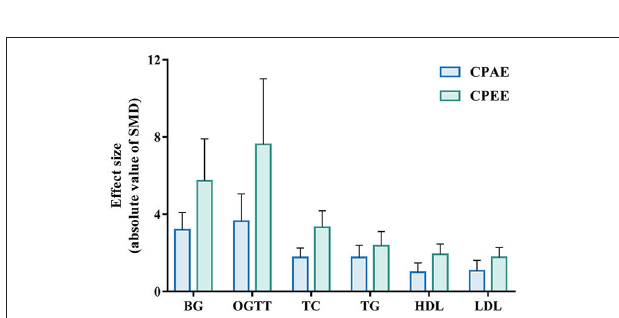
FIGURE 5 | Effect size of CPAE and CPEE on included parameters. CPAE, Cyclocarya paliurus aqueous extract; CPEE, Cyclocarya paliurus ethanol extract; BG, blood glucose level; OGTT, oral glucose tolerance test; TC, total cholesterol; TG, triglyceride; HDL, high-density lipoprotein; LDL, low-density